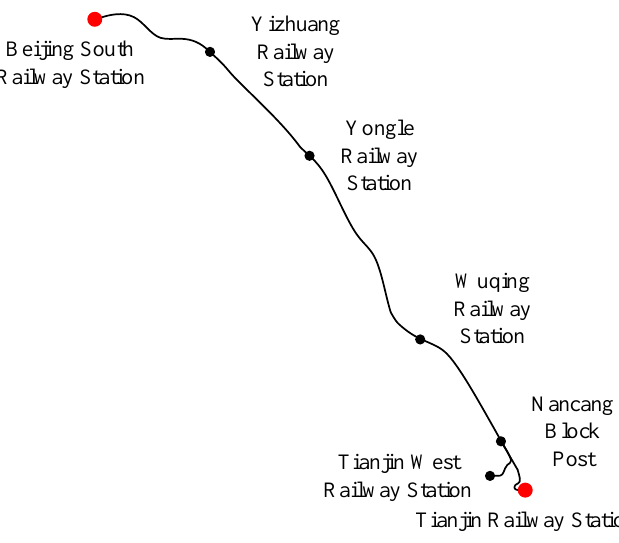
Figure 7. Diagram of the Beijing–Tianjin Intercity Railway line.